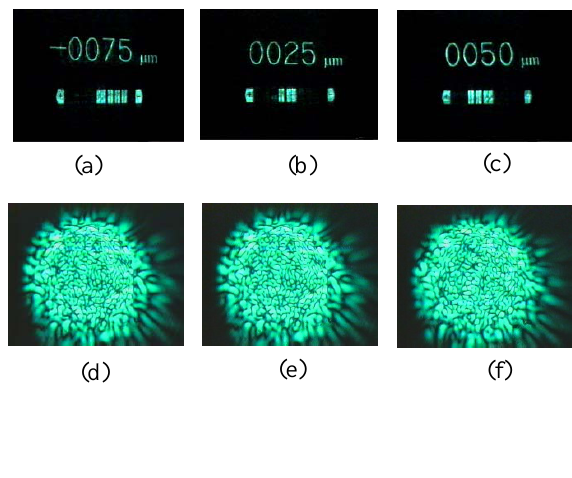
Figure 9. ( a–c ) are three selected diffraction images from the sensor system; ( d–f ) are the reference speckles corresponding ( a–c ),